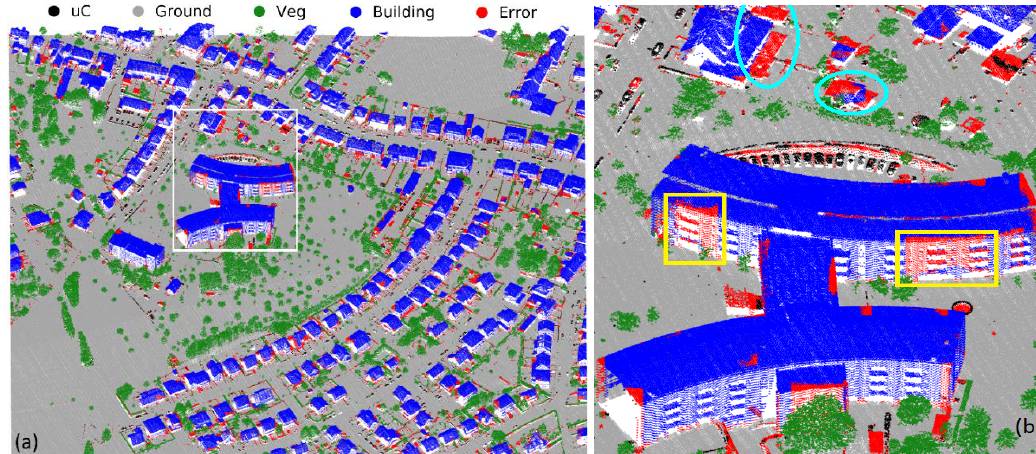
Figure 7 . (a) Semantic segmentation results with errors (false negative, red) for the Dudelange test dataset, and (b) selected area in white rectangle in Fig. 7(a) to magnify the detail, many facade points in the yellow rectangles and roof points in the cyan ellipses are falsely identified (FN, red) as non-building